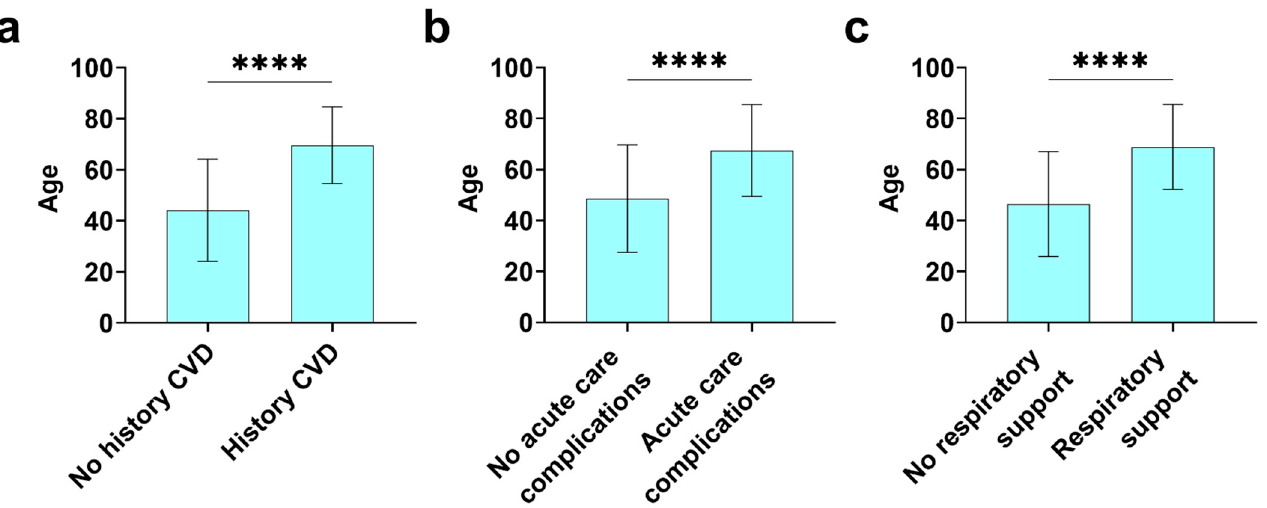
Figure 1. Patients with a history of CVD, acute care complications or in need of respiratory support are significantly older. Patient age at time of COVID infection was assessed between patients with ( a ) no history of CVD ( n = 472) vs. a history of CVD ( n = 207), ( b ) no acute care complications ( n